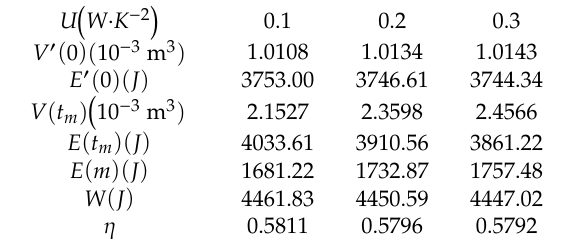
Table 3. Parameters versus U for the case of n =